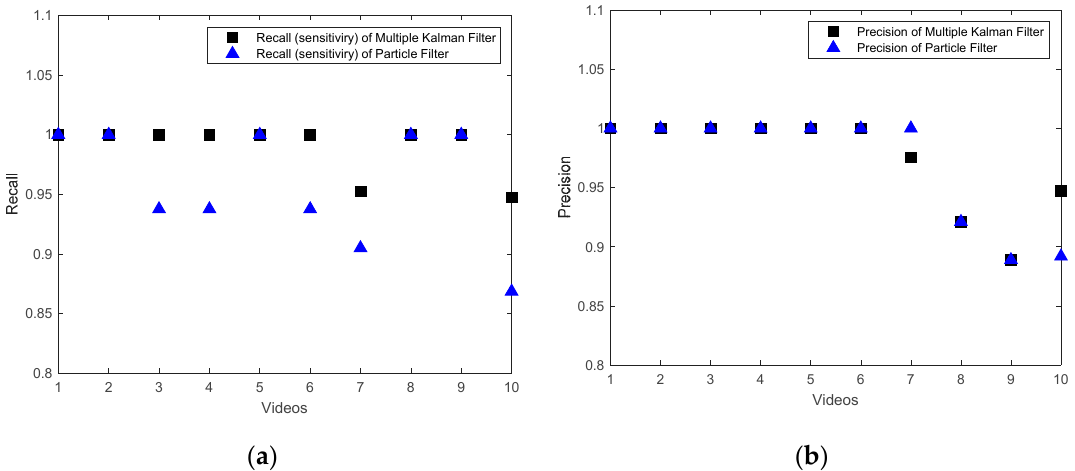
Figure 7. Recall ( a ) and Precision ( b ) of the proposed multi Kalman filter method and the particle filter for the test videos.